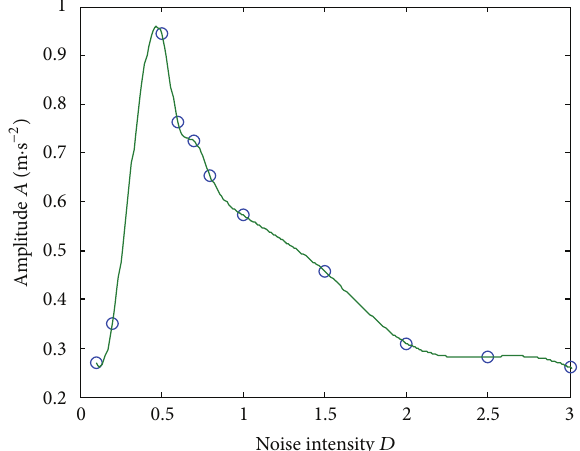
Figure 4: SNR versus noise intensity 𝐷 for different system parameters 𝑐 : − 0.31, − 0.3, and − 0.29. Other parameters are 𝑏 = 0.52 and 𝑑 = 0.04 .